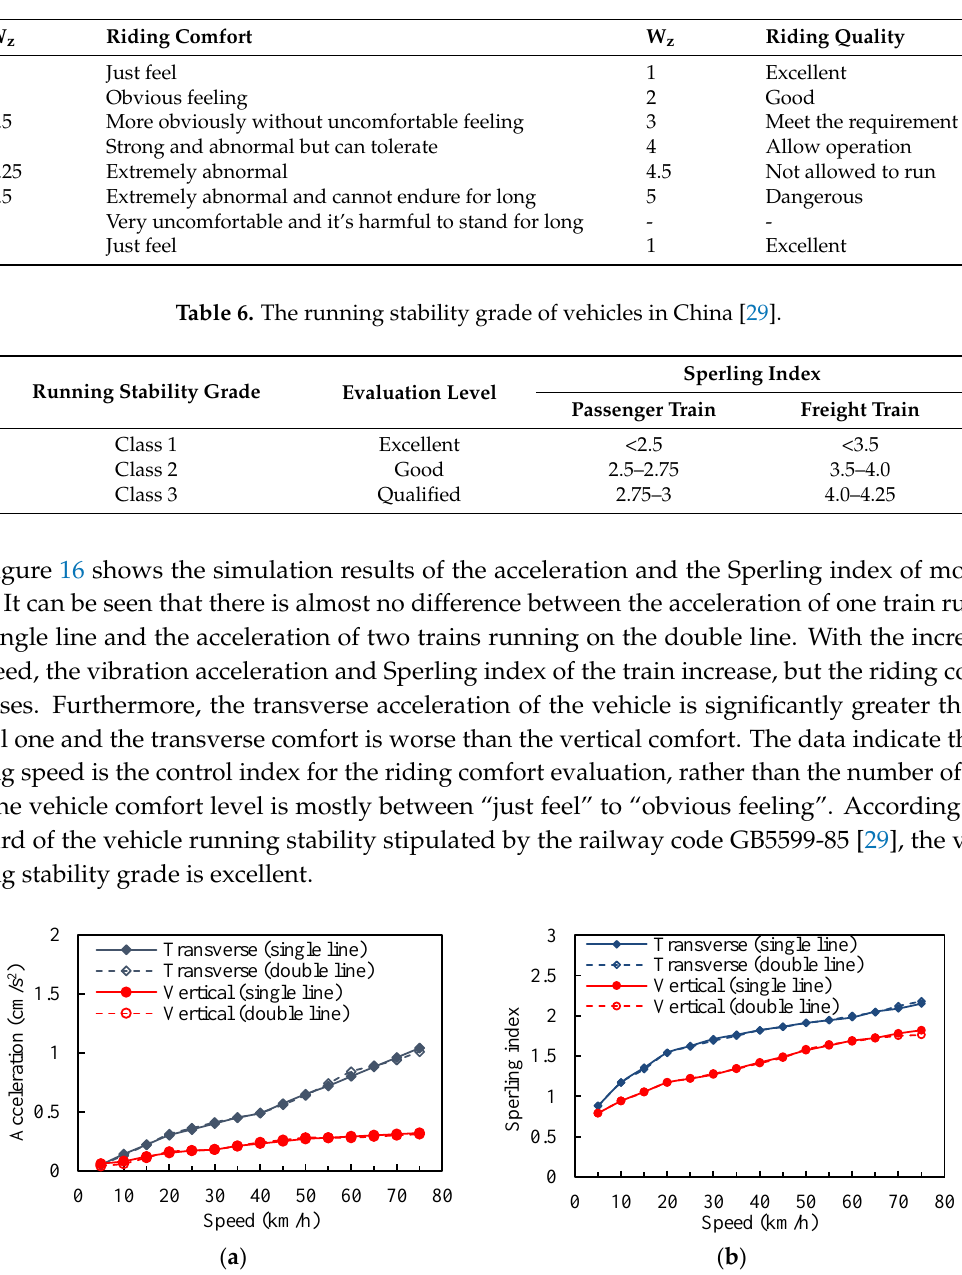
Table 5. The evaluation criteria of the Sperling index.